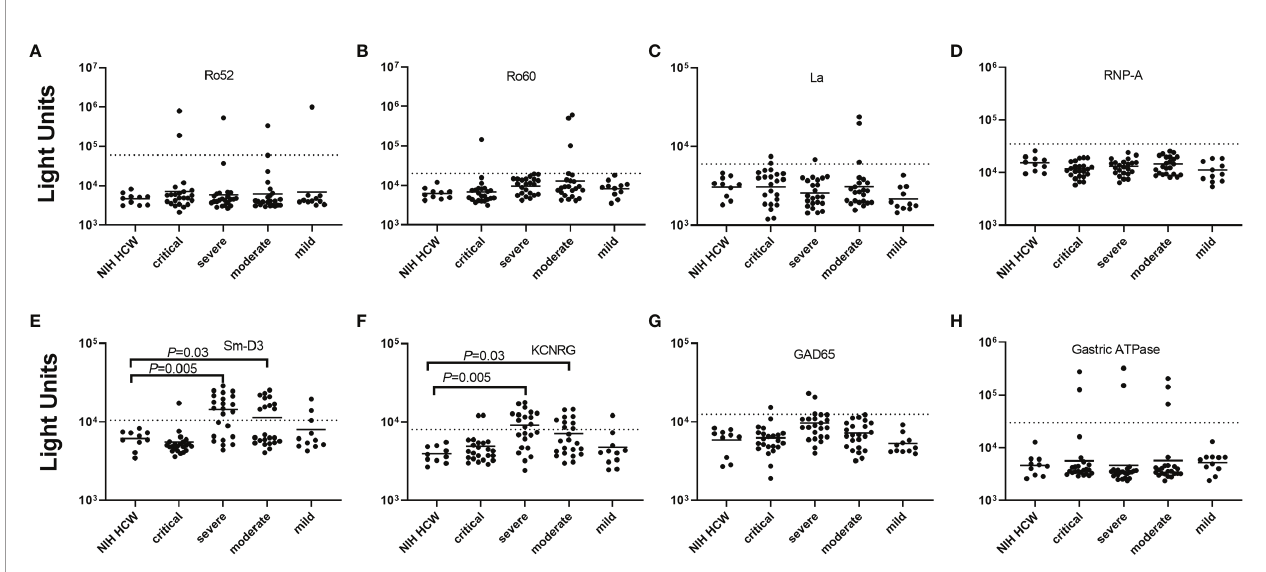
FIGURE 1 | Autoantibodies against known autoantigens in adults with COVID-19 not receiving IVIG. Autoantibody levels against eight well known autoantigens (panels A – H ) were determined in adults with COVID-19 having varying levels of disease severity: critical, severe, moderate, and mild. Each symbol represents a sample from an individual control subject (SARS-CoV-2 uninfected health care worker (NIH HCW), a patient with COVID-19 (critical, severe, or moderate, or mild). Autoantibody levels are plotted in light units on a log 10- scale and the solid horizontal line represents the mean value in each group. The dashed lines represent the cut-off level for determining seropositive autoantibodies as described in the Methods. Only statistically signi fi cant P values from the Fisher exact test examining autoantibody prevalence differences between the uninfected HCW and the different severity groups of COVID-19 adults are shown.